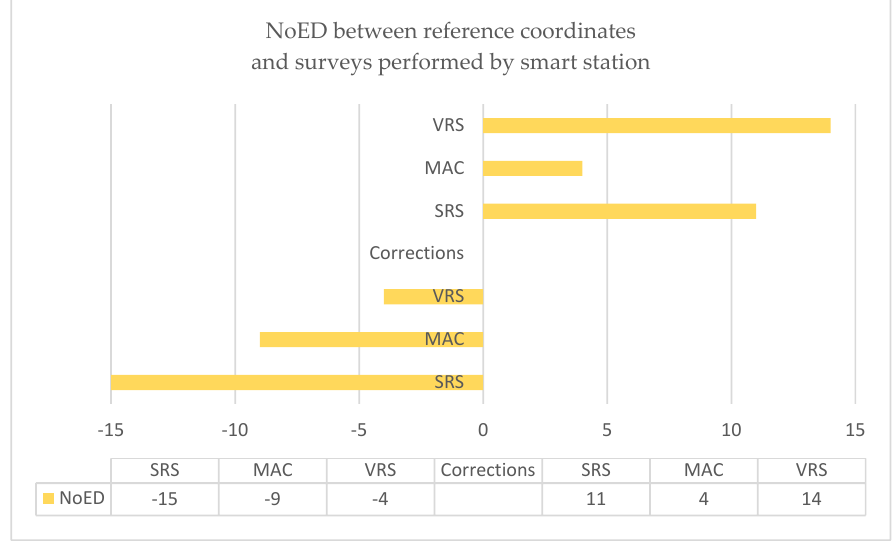
Figure 4. Number of maximum differences in positioning after applying GNSS static occupation and with use the individual type of corrections in multi-variant measurements. Table 3. Differences of coordinates after applying GNSS static occupation and with use of the indi- vidual type of corrections in multi-variant measurements.